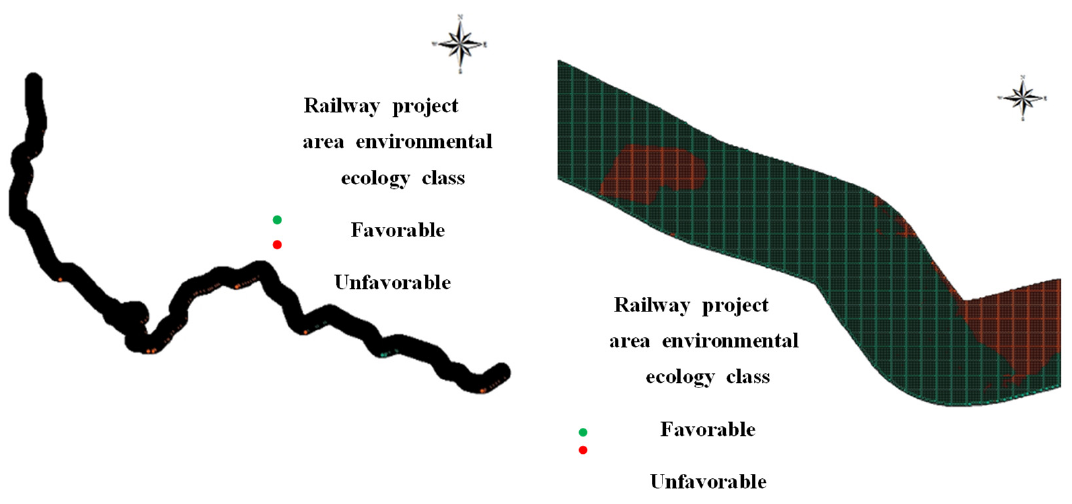
Figure 2. Evaluation of sampling points with raster data.